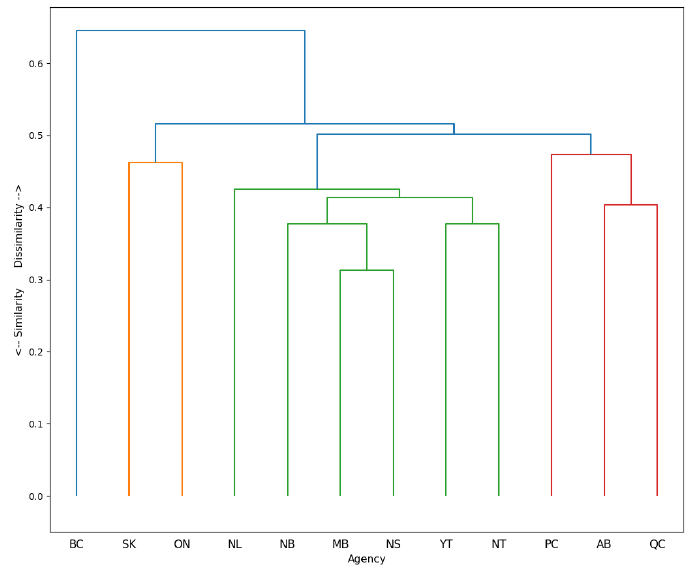
Figure 6. Dendrogram illustrating fire management agencies in similar clusters considering all indicators in the study. Agencies that are clustered first, starting from the bottom of the plot moving upward, are most similar. For example, we see that see that MB and NS are the most similar in terms of overall coded responses (they group first). Next, NB joins with MB and NS. Later, YT and NT are grouped since they are approximately as similar to each other as NB is to MB and NS.